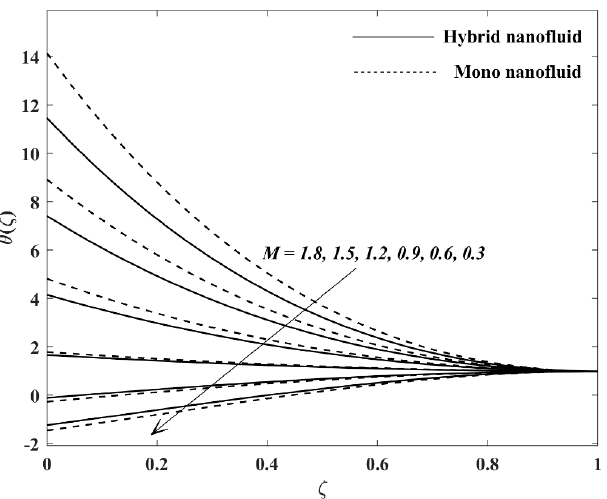
We S , and = 0.6 m , changes in Figure 5. Under the given conditions of ε= = = = − 0.05, 0.8,Pr 7, 1 Figure 5. Under the given conditions of We x = 0.05, ε = 0.8,Pr = 7, S = − 1, and m = 0.6, changes in x